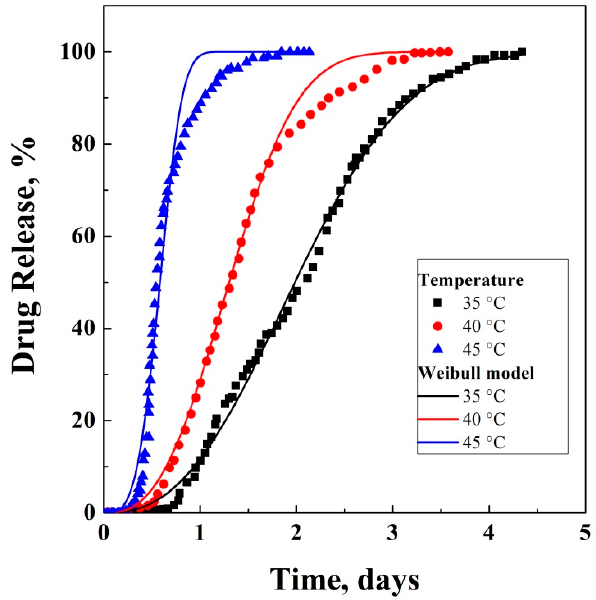
Figure 5. Drug release test comparison from liposomes, as an effect of liposomes produced at different temperatures.